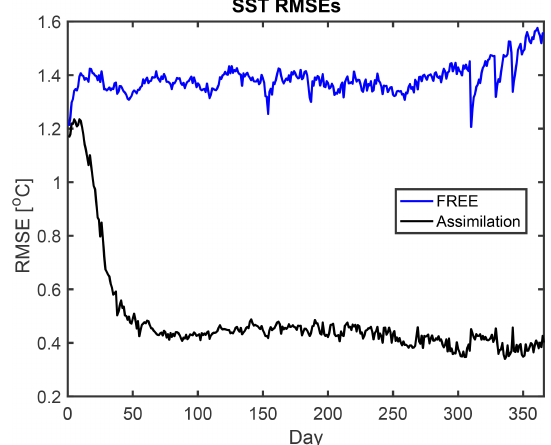
Figure 7. Root-mean-square errors of the estimated SST with re- gard to the assimilated SST observations. Shown are the free run (blue) and the SST assimilation experiment (black). During the spin-up period of the DA, the RMSEs are strongly